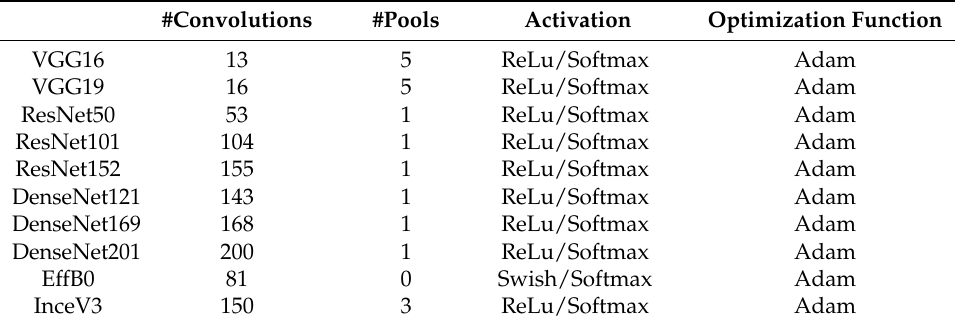
Table 2. Architecture details of used CNN models.